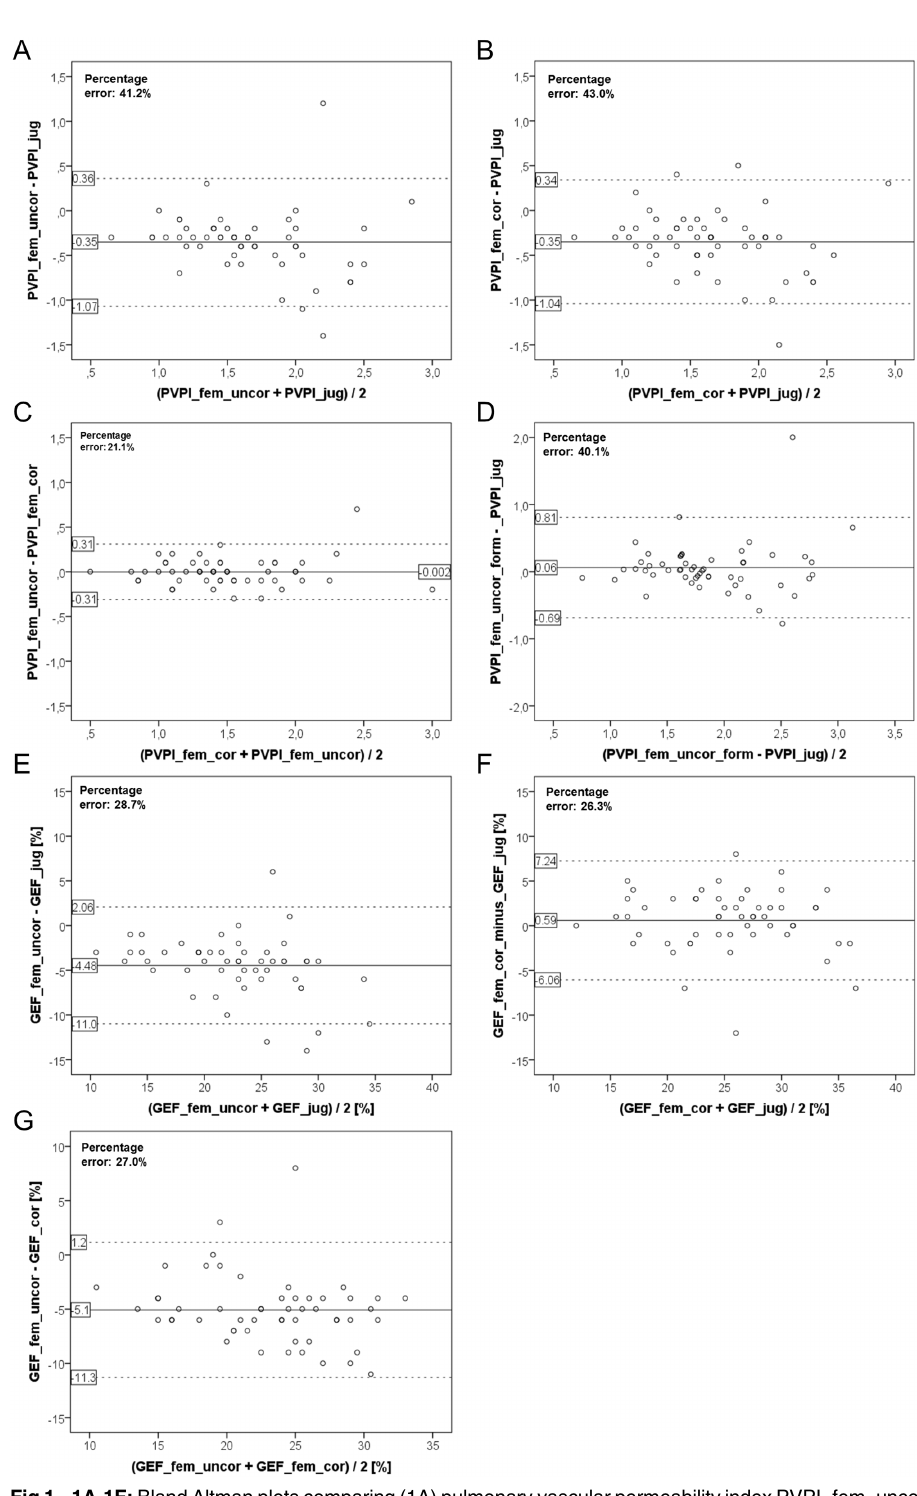
PLOS ONE | https://doi.org/10.1371/journal.pone.0178372 October 17,